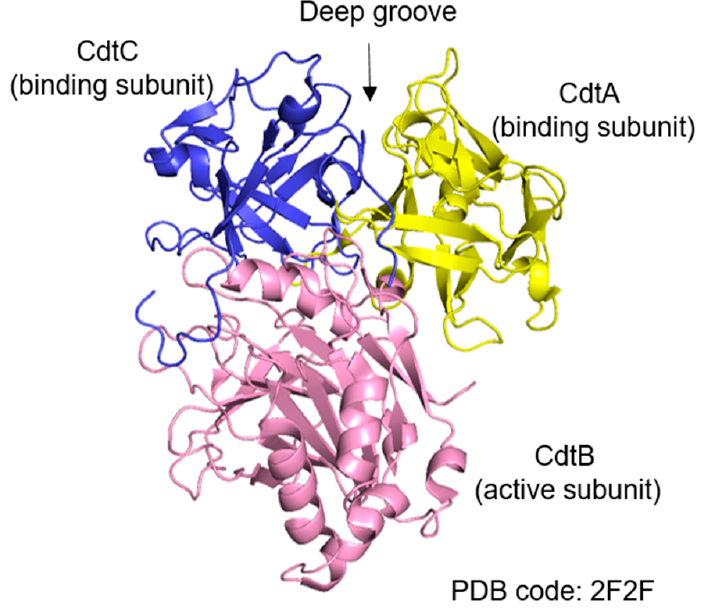
Figure 1. The PDB structure of the CDT toxin from Actinobacillus actinomycetemcomitans . The yellow color indicates the CdtA subunit, the pink color is for the CdtB subunit, and the blue color codes for the CdtC subunit. CdtA and CdtC together form a deep grove.